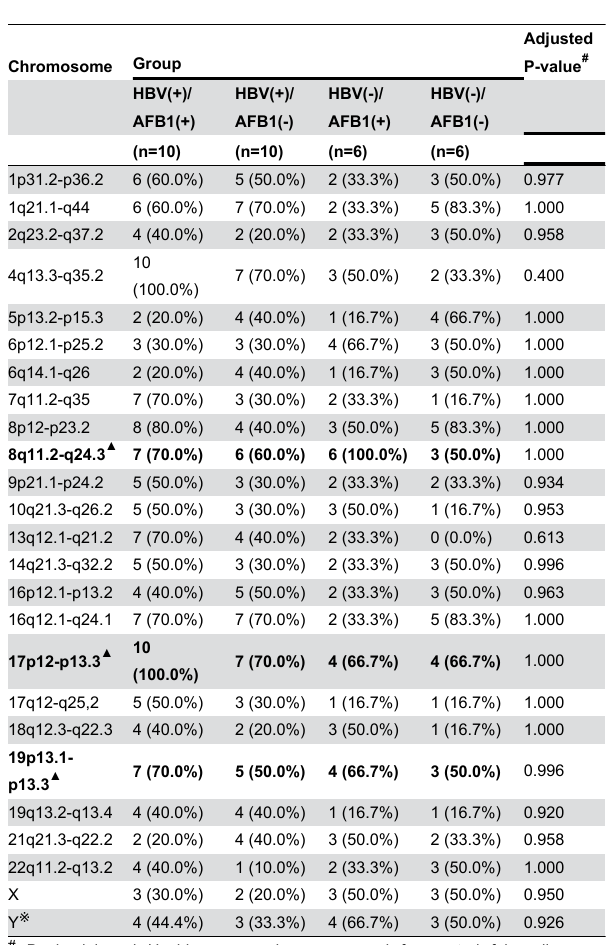
Table 2. The comparison of incidence of RARs in 32 HCCs by HBV and AFB1